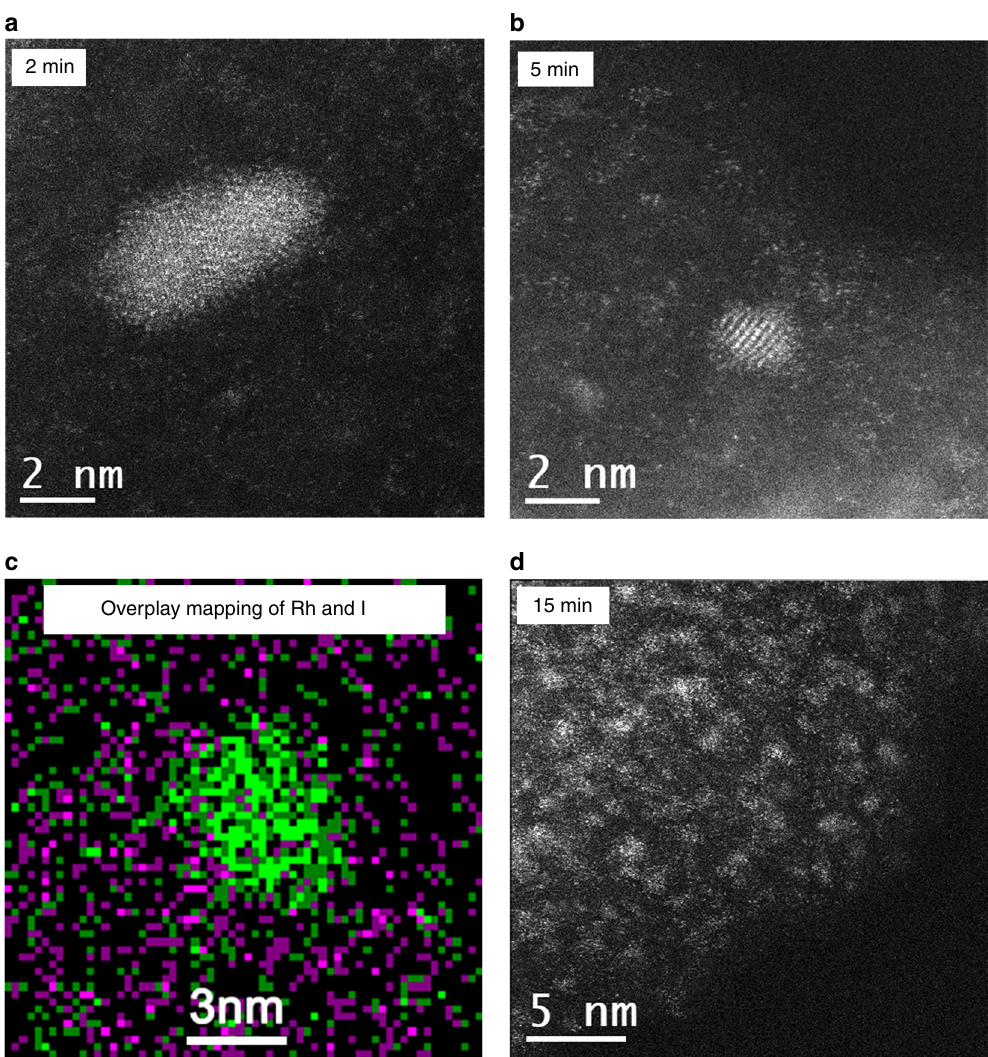
Fig. 2 Time resolution HAADF-STEM pictures of Rh/AC dispersion. The sample treated by CO/CH 3 I at 513 K for a 2 min, b 5 min, and c the corresponding Rh and I atomic EDS mapping of Fig. 2 b , d , 15 min. Green color denotes Rh element and pink color denotes I